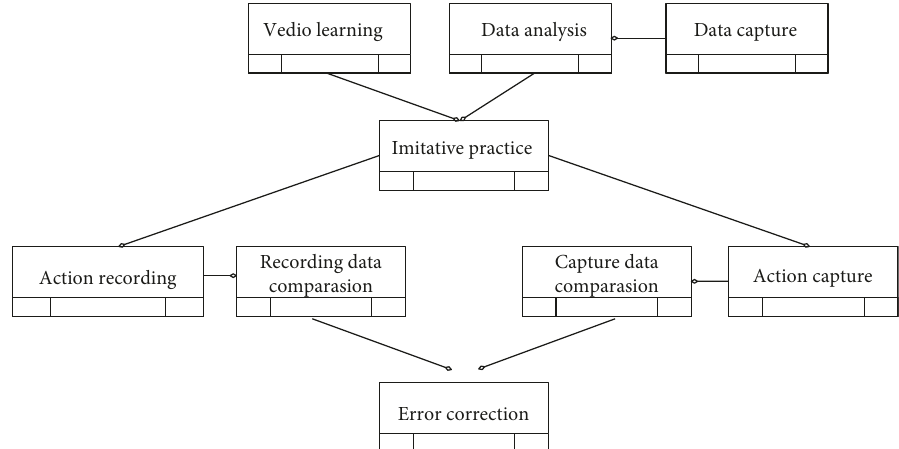
Figure 13: Motion capture system for sports dance teaching based on digital filtering